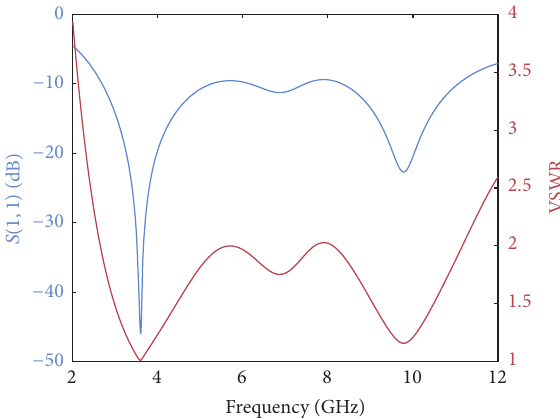
Figure 4: Frequency behavior of the UWB monopole antenna input reflection coefficient.